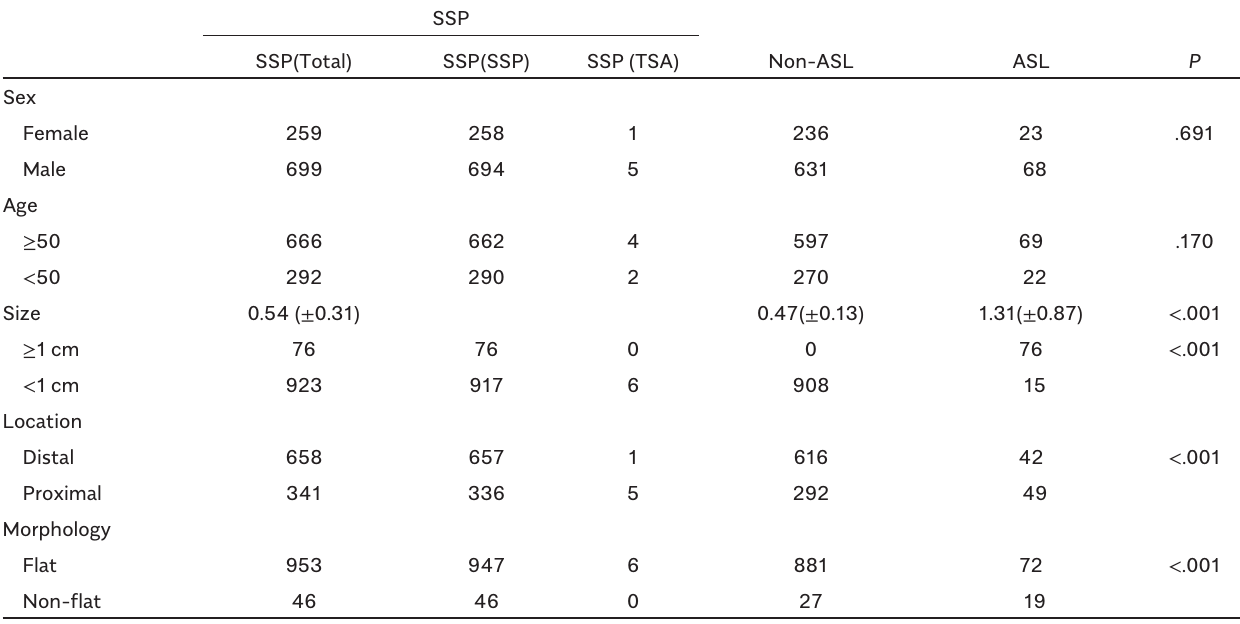
Table 2. Characteristics of Sessile Serrated Polyps